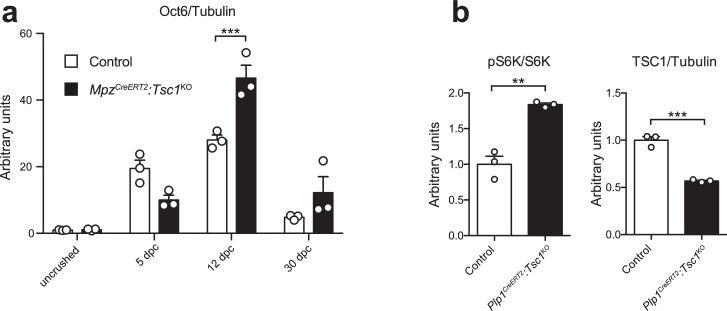
Quantification of western blots.Bar height: mean; error bars: s.e.m. (a) Quantification referring to Figure 6h. Uncrushed control average is set to 1 (n = 3 mice/genotype for every time point, including the biological replicates representatively shown in Figure 6h, two-way ANOVA with Sidak’s multiple comparisons test, F(3,16) = 11.62, p=0.0003; p12dpc = 0.0003). (b) Quantification referring to Figure 6j. Control average is set to 1 (n = 3 mice/genotype, including the biological replicates representatively shown in Figure 6j, two-tailed unpaired Student’s t-test; pS6K/S6K, t(4) = 7.29, p=0.0019; TSC1/Tubulin, t(4) = 11.34, p=0.0003). **p<0.01, ***p<0.001.